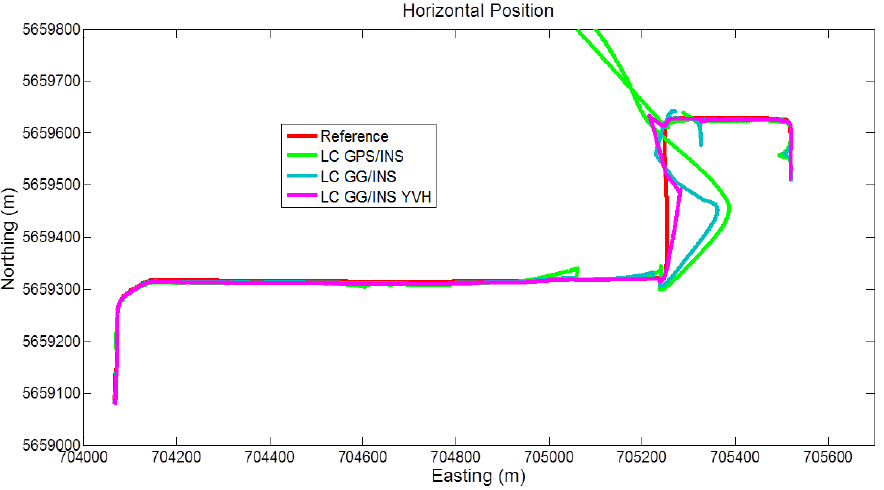
Figure 10. Trajectories obtained with the loose coupling approach (Segment 1).